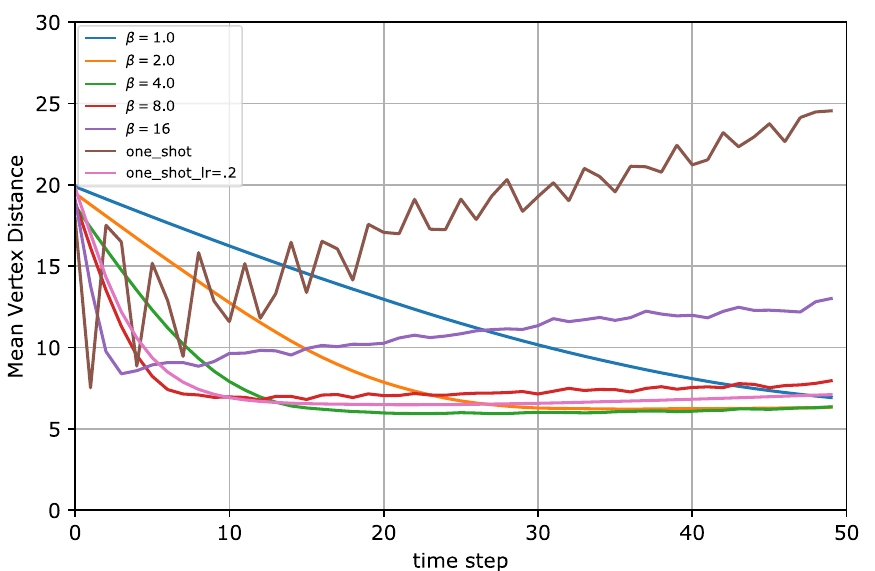
Figure 5. The impact of different acceleration factors β w.r.t to the mean vertex distance of the segmentation. We also compare results obtained using one-shot prediction (one_shot), vs one-shot with learning rate (one_